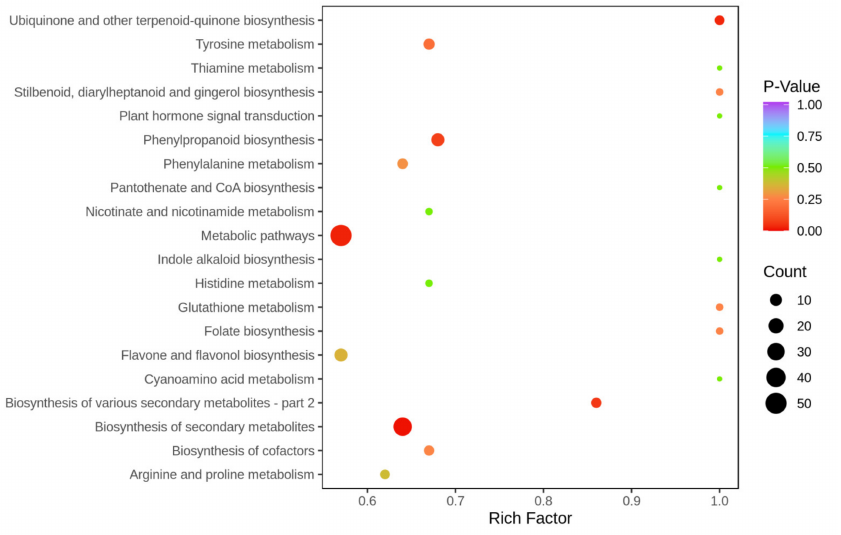
Figure 5. Top 20 enriched KEGG pathways for differential metabolites of AC and